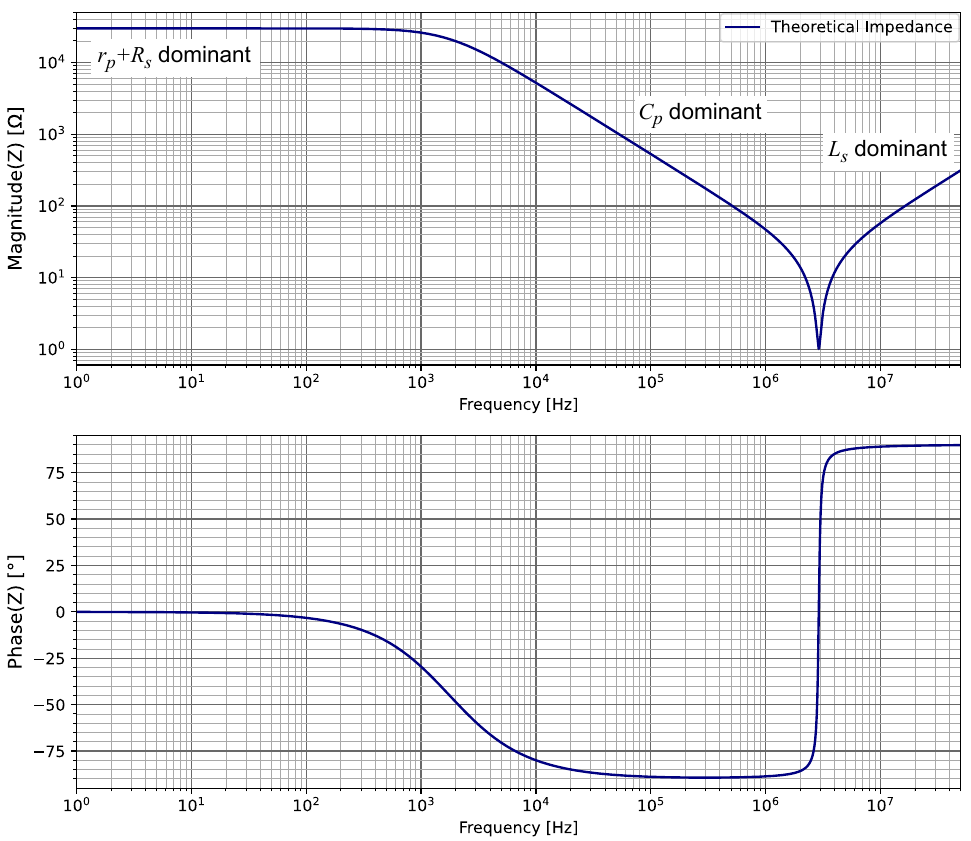
Figure 10. Theoretical magnitude and phase plots for the Schottky diode AC small-signal